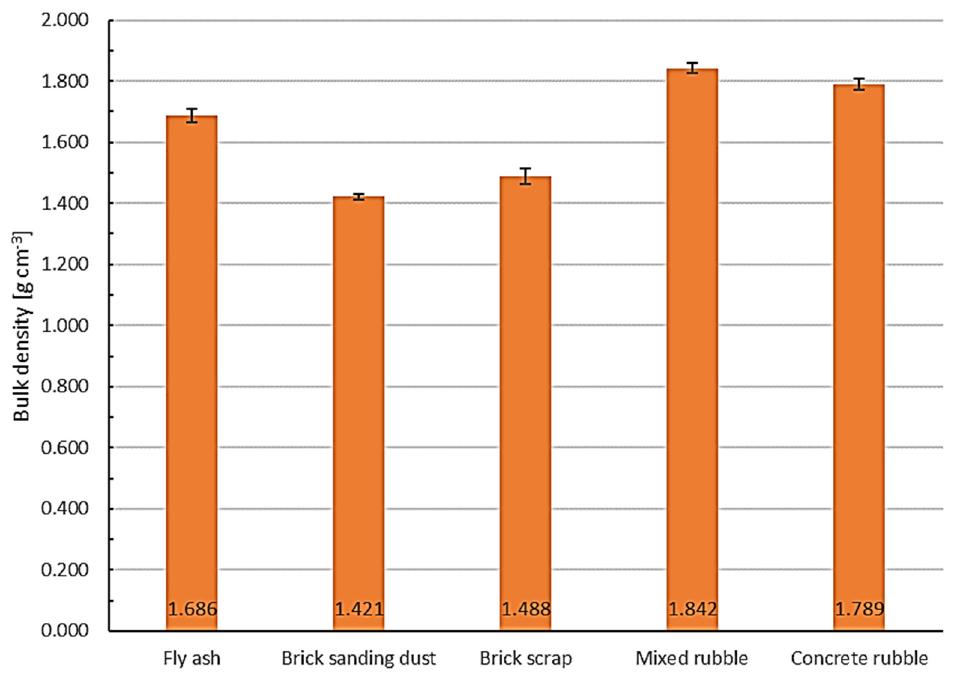
Figure 8. Mean values of bulk density of geopolymer bricks produced from residual materials with associated standard deviations.